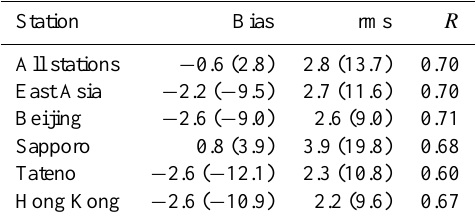
Table 2. Validation results for the lower-tropospheric ozone columns. The bias (IASI − sonde), the rms and the correlation co- efficient are provided for all stations listed. The bias and the rms are given inDU, with the percentage in